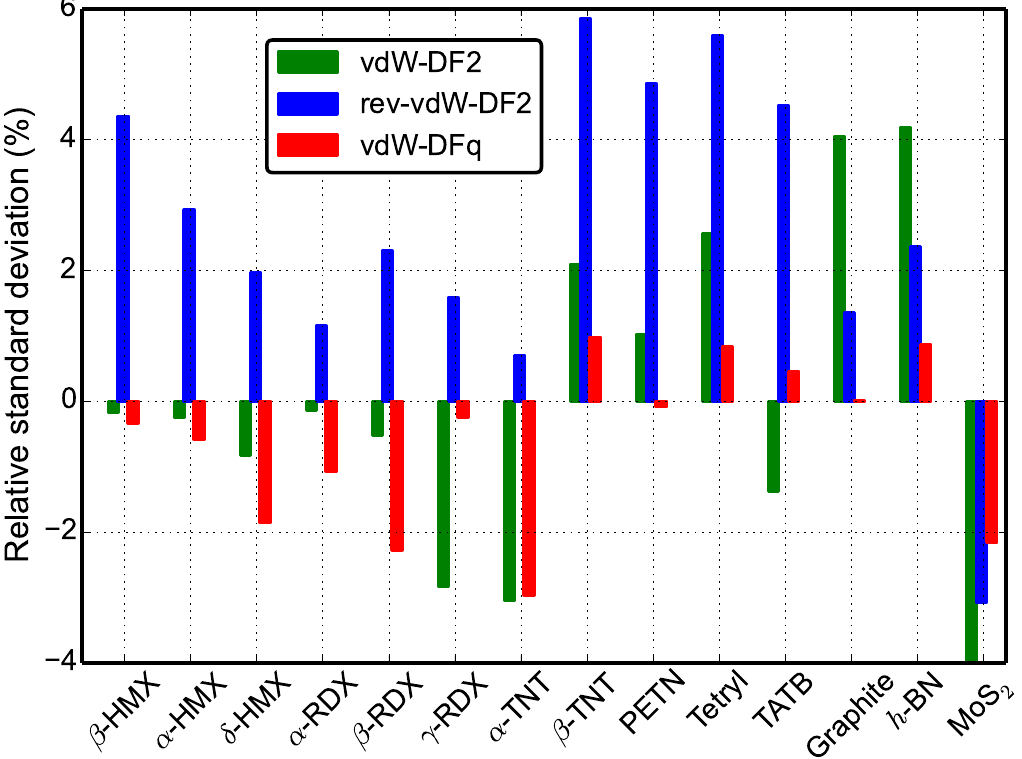
Figure 5. Relative standard derivative of the predicted mass density of the semihard materials. The mass density RSD referring to the experiments using vdW-DF2, rev-vdW-DF2, and vdW-DFq method for 11 common energetic materials molecular crystals and 3 typical layered van der Waals